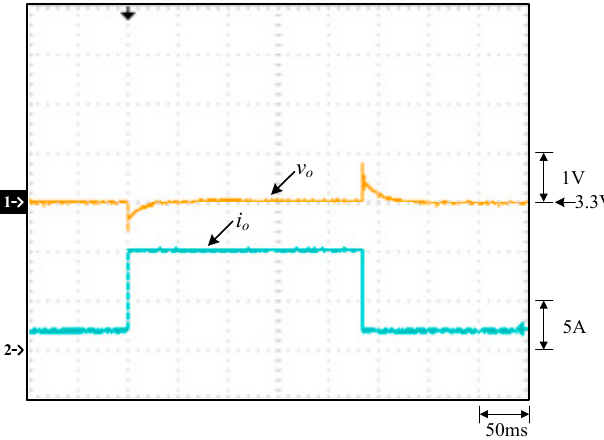
Energies 2019 , 12 , x FOR PEER REVIEW Figure 22. Output voltage responses due to load transients from light / rated load to rated / light load. Figure 22. Output voltage responses due to load transients from light/rated load to rated/light load.